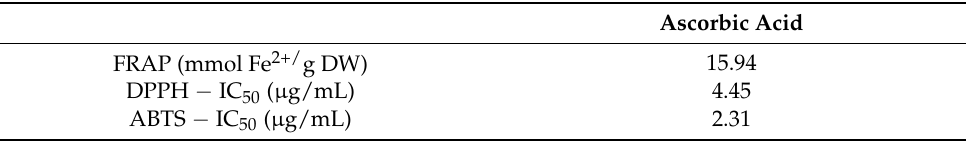
Table 5. Antioxidant activity of positive control (ascorbic